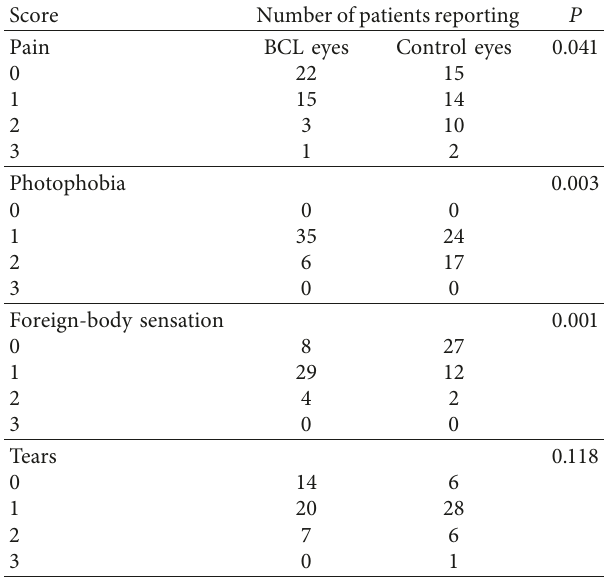
Patients underwent bilateral femtosecond laser-assisted in situ keratomi- leusis (FS-LASIK surgery) followed by application of a bandage contact lens (BCL) to one eye (BCL eyes) but not the other (Control eyes). Symptom scores were self-reported: 0, not present; 1, mild; 2, moderate; 3, severe.